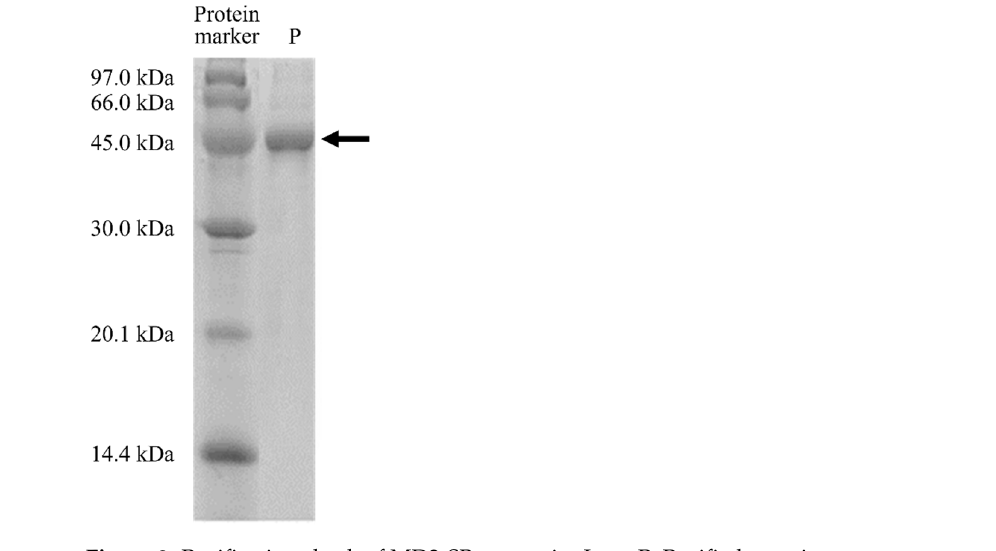
Figure 2. Purification check of MD2-SBro protein. Lane P: Purified protein.